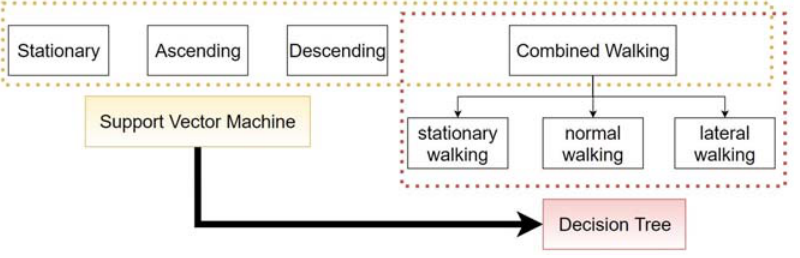
Figure 5. The hierarchical combination of SVM and DT to recognize heading steady activities.